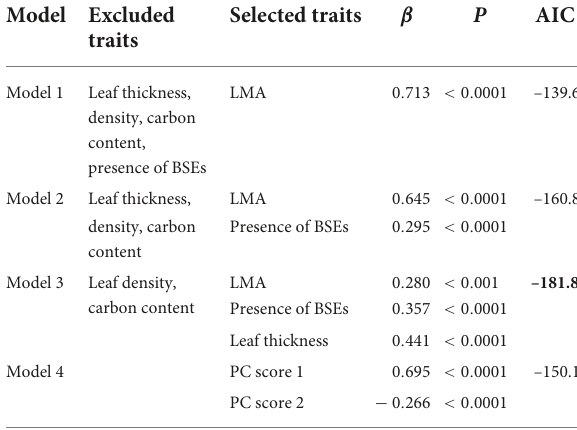
TABLE 5 Comparison of models including different trait combinations to explain the variation in leaf toughness. Model Excluded traits